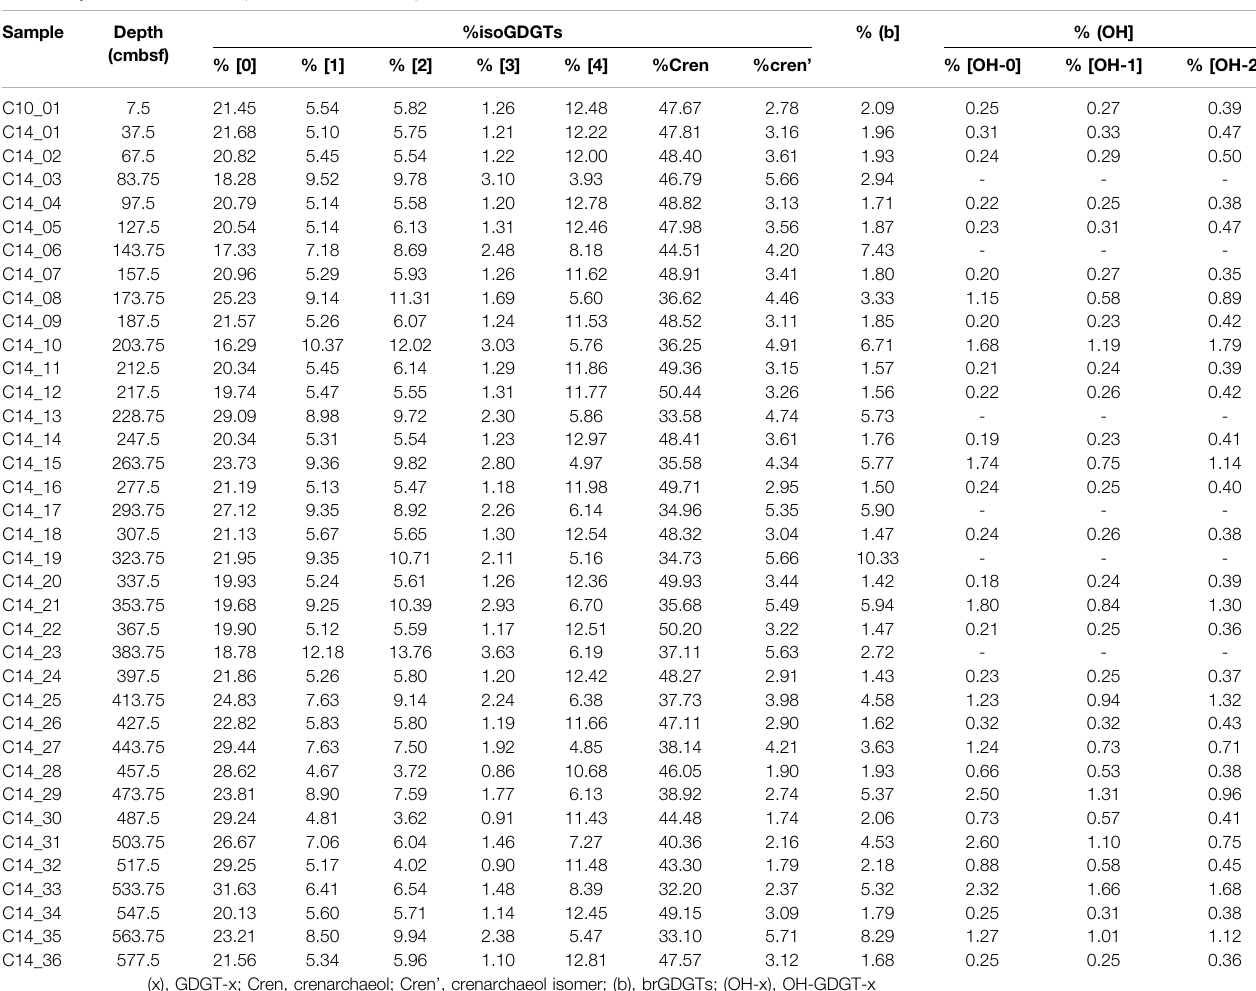
TABLE 3 | The contribution of speci fi c GDGTs with depth in core C14. Sample Depth